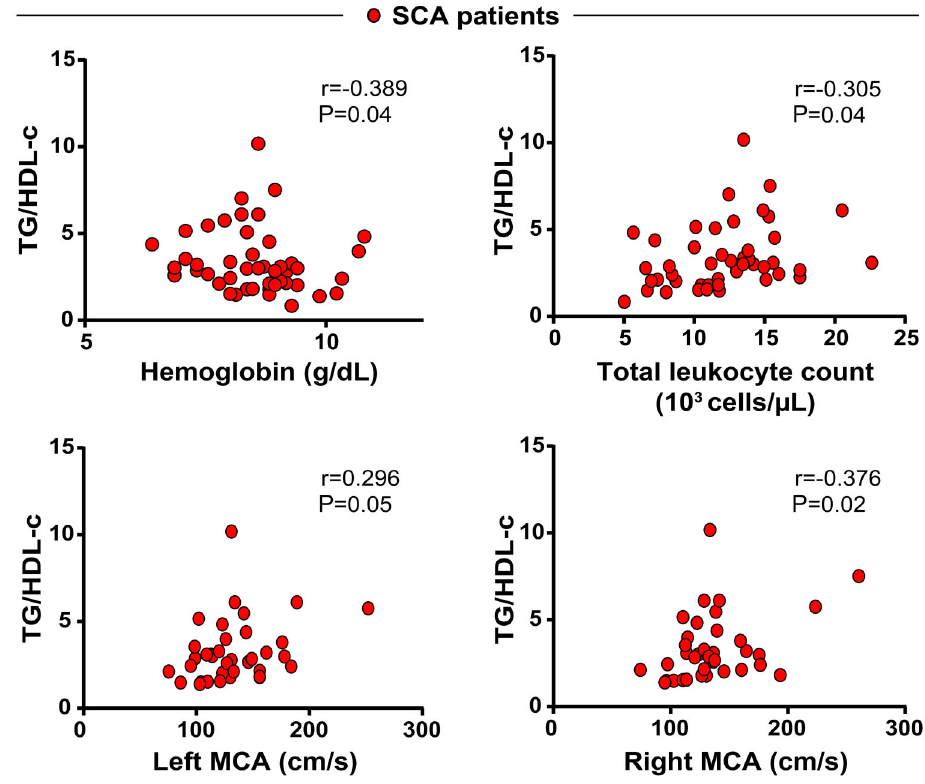
Figure 1. Spearman correlations analysis of severity parameters and triglycerides (TG):high-density lipoprotein cholesterol (HDL-c) ratio in sickle cell anemia (SCA) patients. MCA: middle cerebral artery.